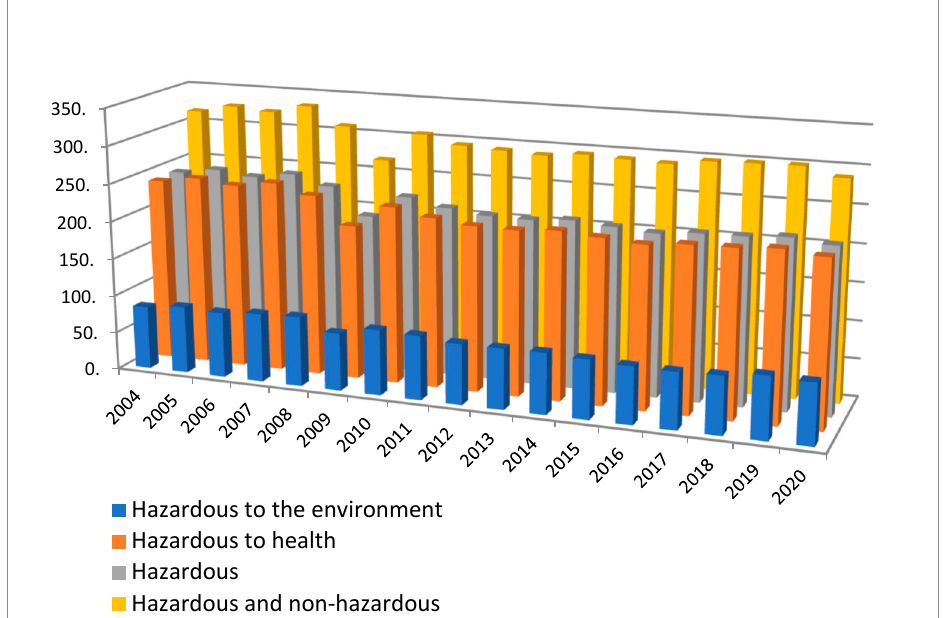
Figure 8. Consumption of chemicals.